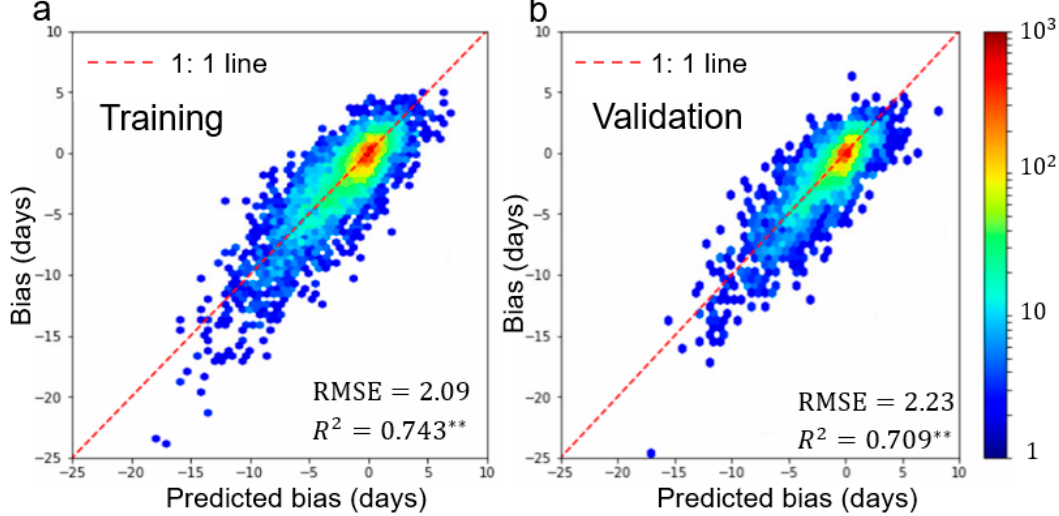
Figure 10. Performance of the multi-endmember model at the scale of 450-m resolution for the ( a ) training dataset ( b ) and validation dataset. ** p < 0.01.